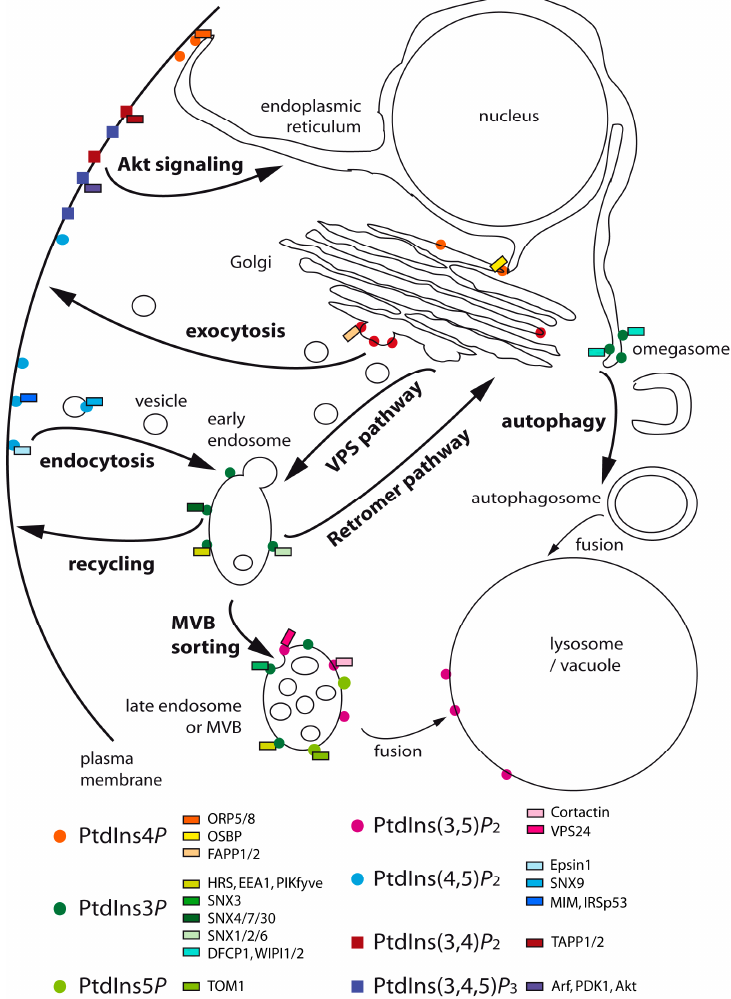
Figure 2. Intracellular localization of the different phosphoinositides and the membrane trafficking pathways. The different phosphoinositides (PPIn) are represented by symbols: circles for PPIn involved in intracellular trafficking with the corresponding steps they regulate; squares for PPIn involved in cell signaling, the latter being absent from yeast. The human proteins interacting with the different PPIn are represented by a rectangle. The MVB stands for multivesicular body and the VPS for vacuolar protein sorting.